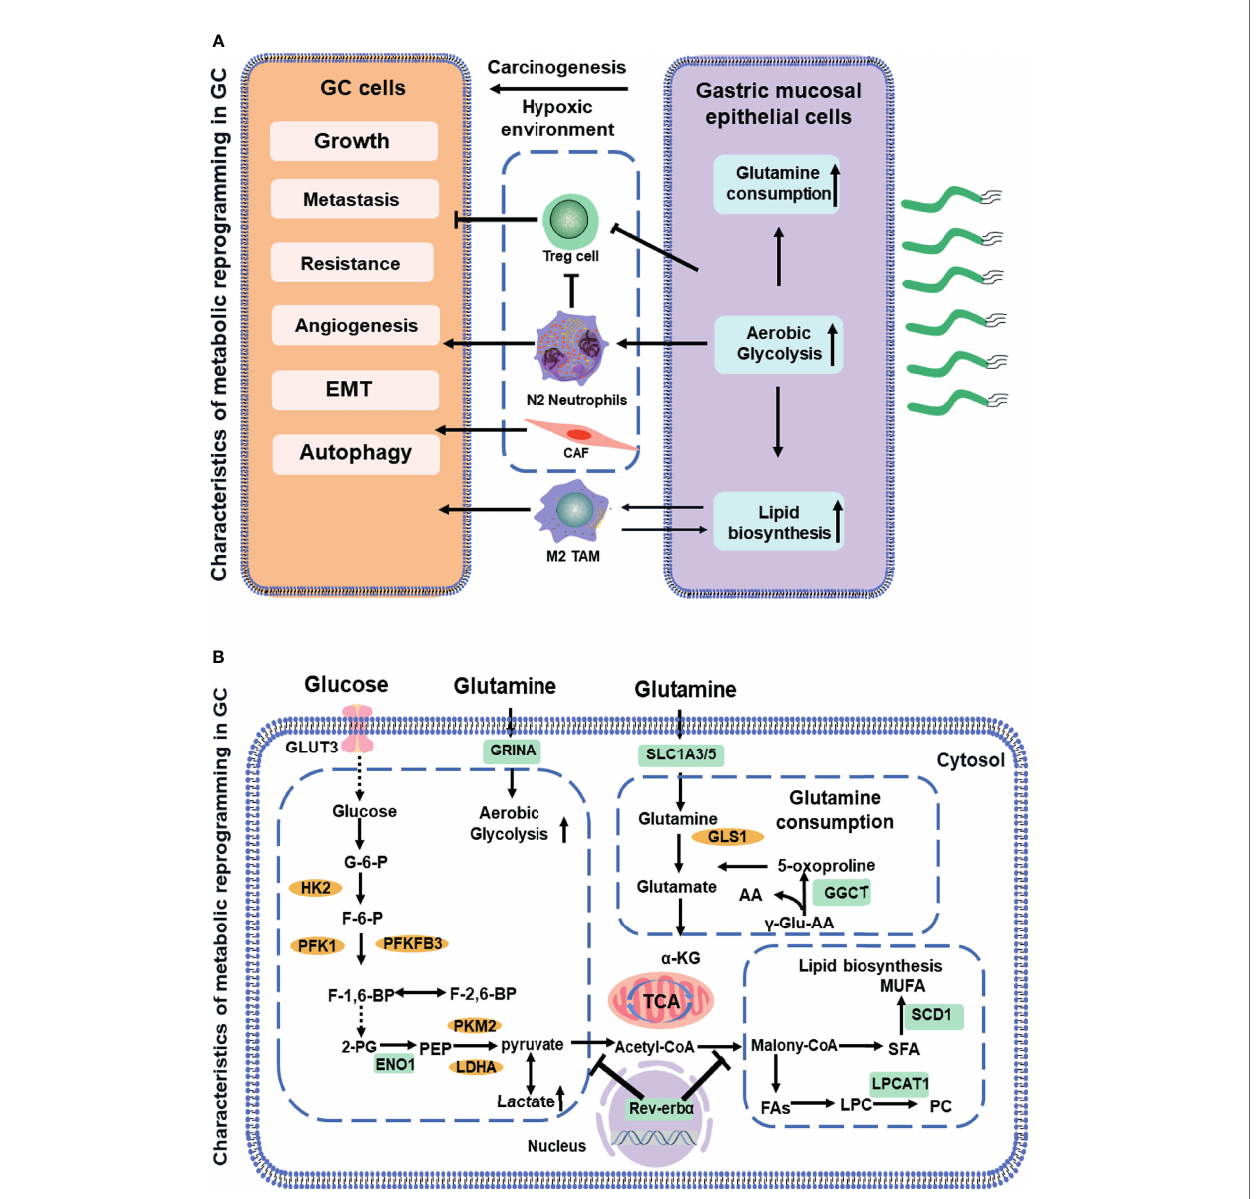
FIGURE 1 | Schematic showing a comparative account of normal vs. cancer cell metabolic reprogramming (A) . The association between aerobic glycolysis (Warburg effect) and the glutamine metabolism and fatty acids metabolism. Biomarkers in GC (indicated in green boxes) along with signaling molecules (orange circles). Next, the mitochondrial dysfunction or phenotypic alteration (B) . AA, amino acid; CoA, coenzyme A; ENO1, enolase 1; F-6-P, fructose 6- phosphate; FA, fatty acids; G-6-P, glucose-6-phosphate; GGCT, glutamylcyclo transferase; GLUT3, glucose transporter3; GRINA, glutamate receptor; GLS, glutaminase1; HK2, hexokinase2; LDHA, lactate dehydrogenase; LPC, lysophosphatidylcholine; LPCAT1, lysophosphatidylcholine acyltransferase; MUFA, multiunsaturated fatty acid; PEP, phosphoenolpyruvate; PFK1, phosphofructokinase1; PC, phosphatidylcholine; PFKFB3, phosphofructokinase-2/fructose-2,6 bisphosphatase 3; PKM2, pyruvate kinase2; SFA, saturated fatty acids; SCD-1, stearoyl-CoA desaturase 1; TCA, tricarboxylic acid cycle. Dotted lines indicate the feed-back inhibition/regulation of some of the glycolytic enzymes by corresponding